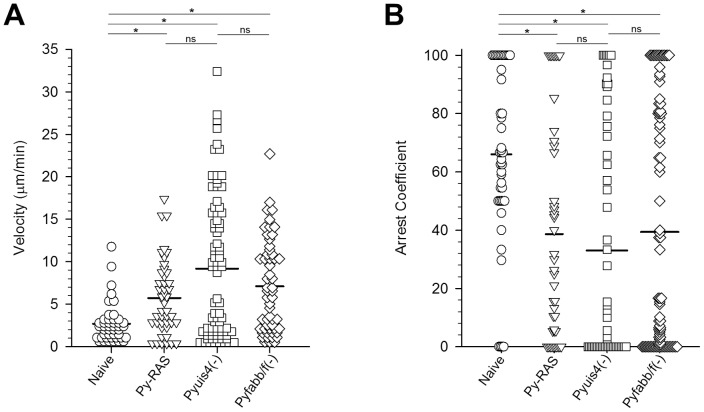
Tracking CD8+ cells in naïve and immunized mouse livers.CD8+ T cells were identified by anti-CD8a-PE labeling in the livers of naïve mice (circles) or mice immunized with Py-RAS (triangles), Pyuis4(−) (diamonds), or Pyfabb/f(−) (squares) and monitored via IVM. Velocities (A) and arrest coefficients (B) were calculated from the tracks of individual CD8+ T cell from at least 2 infected mice per group. One-way ANOVA on Ranks shows that the velocities of the CD8+ T cells from all immunized mice are significantly higher and the arrest coefficients significantly lower than those of the CD8+ T cells from naive mice (p<0.05). The same statistical analysis does not reveal any significant difference between the CD8+ T cell velocities between the groups of immunized mice (p>0.05). *  =  p<0.005, ns  =  not significant. CD8+ T cells of immunized mice were monitored at least 2 weeks after the second booster.